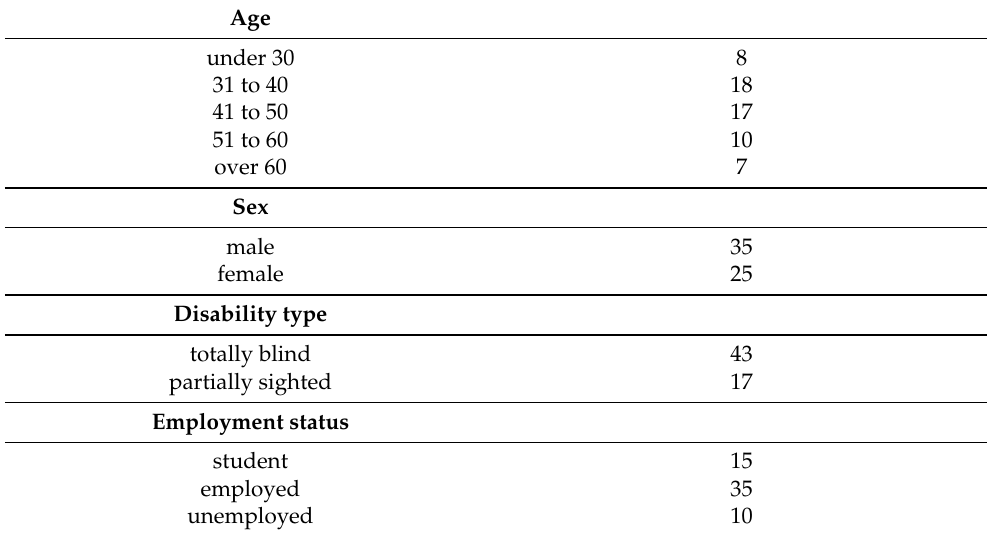
Table 1. Participants’